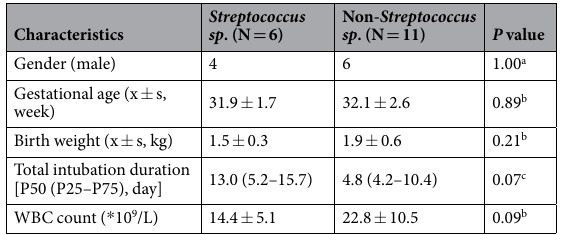
Table 5. Comparison of demographic and clinical characteristics between the Streptococcus sp . and the non- Streptococcus sp . groups among NRDS patients with VAP in the study. a Based on Fisher’s exact test. b Based on unpaired Student’s t-test. c Based on Mann–Whitney U